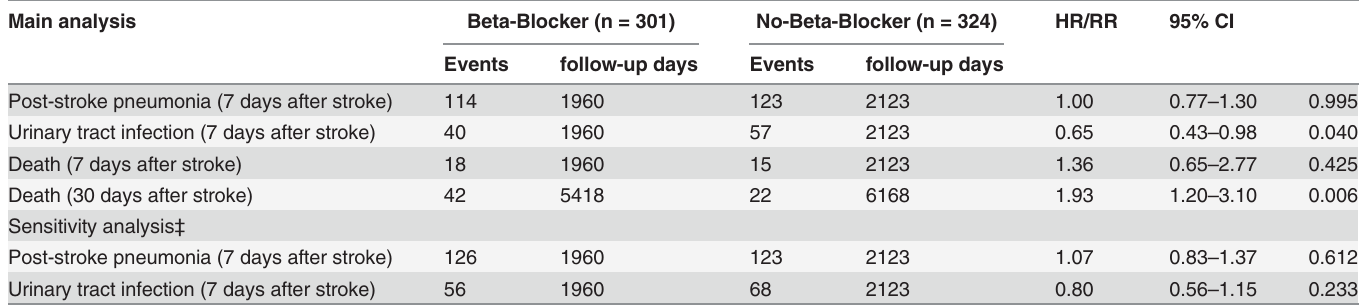
Table 2. Post-stroke pneumonia, urinary tract infection and mortality in patients with and without beta-blocker therapy (n = 625).